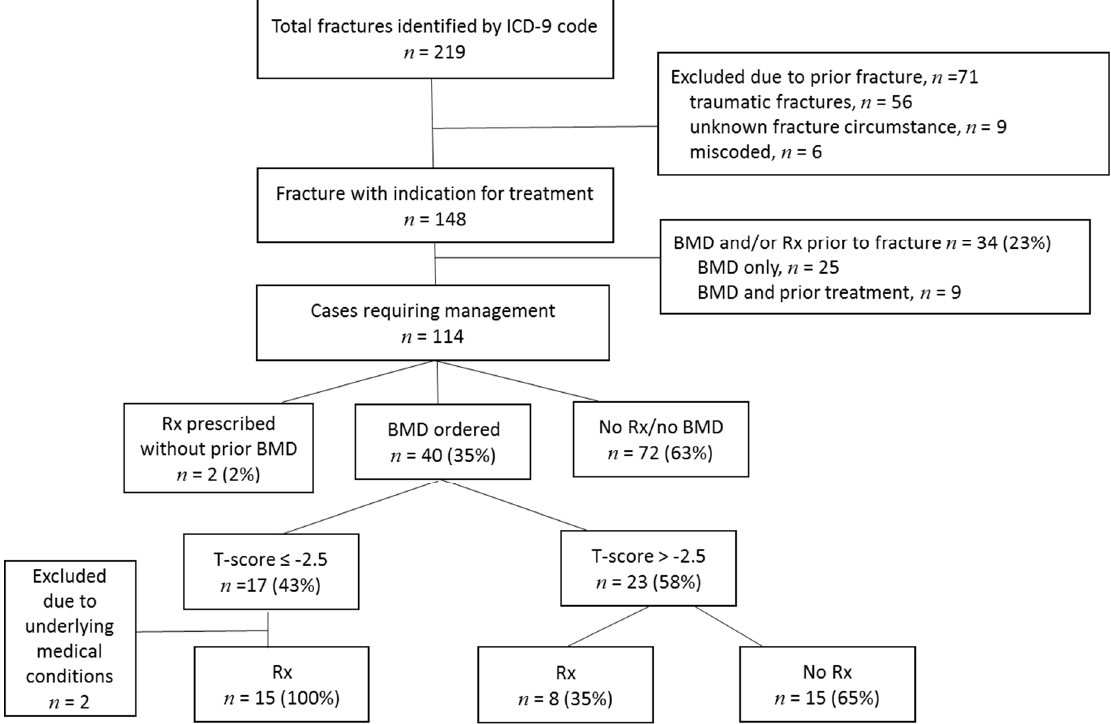
Figure 1. Study algorithm. BMD: bone mineral density; ICD: International Classification of Disease; Rx: prescription.